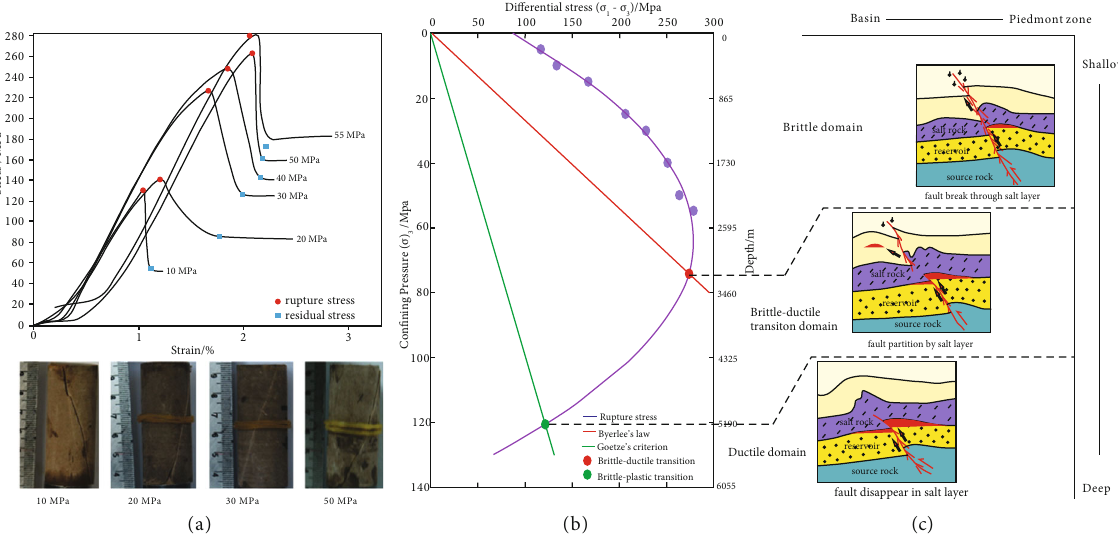
Figure 7: Results of triaxial compression tests on E km salt rock, showing the conditions of the brittle – ductile transition and di ff erent 1 – 2 fault – salt combinations in various deformation domains. (a) Triaxial compression test results for E km salt rock samples at di ff erent 1 – 2 con fi ning pressures. (b) Brittle – ductile transition conditions of Kuqa E km salt rock samples determined by triaxial compression test 1 – 2 results and according to Byerlee ’ s law and Goetze ’ s criterion. (c) Sketch map showing the di ff erent fault – salt combinations occurring in various deformation domains for salt